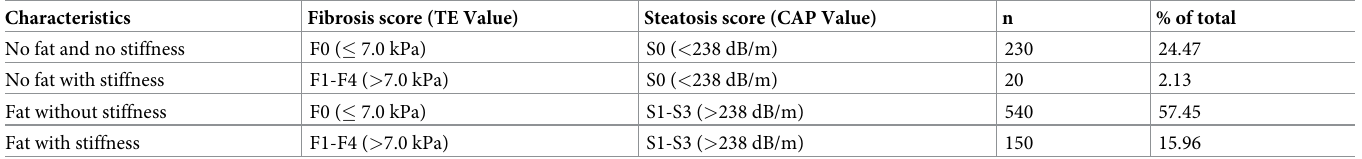
Table 4. Breakdown of study population based on fibrosis and steatosis categorization.